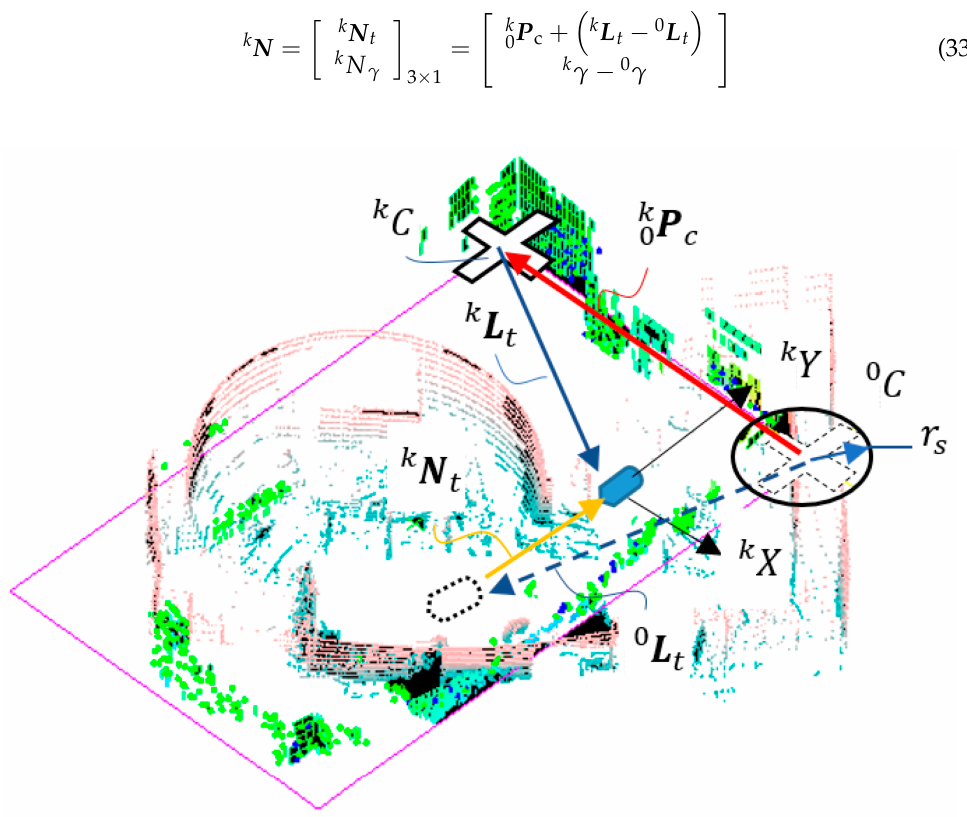
Figure 9. Determination of the previous